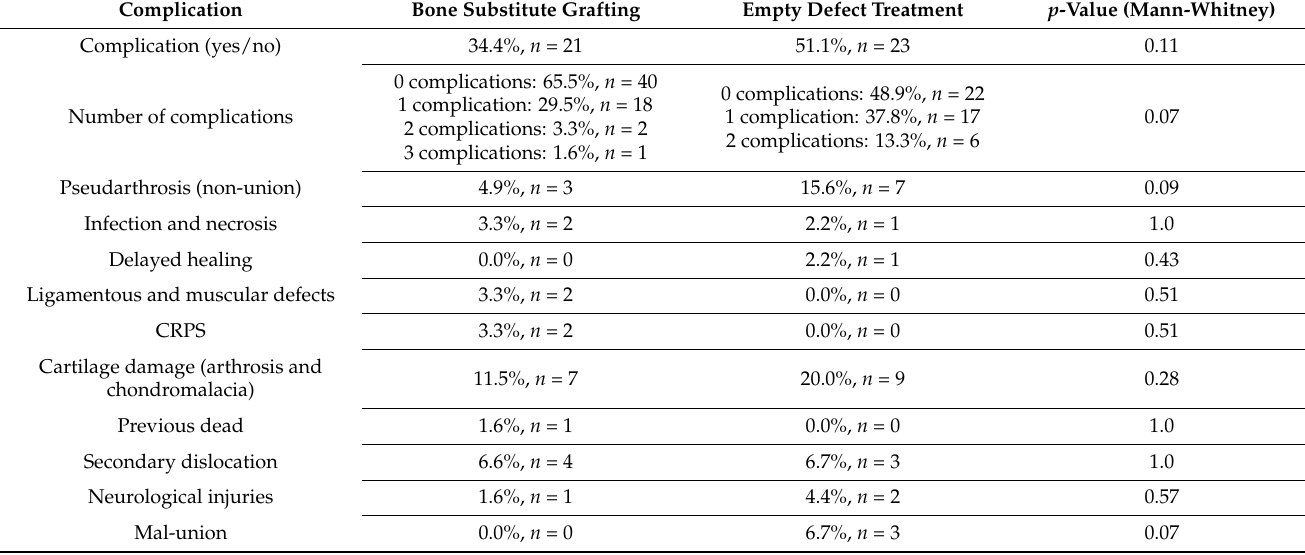
Table 1. Overview of complications suffered in the groups using bone substitute grafting and empty defect